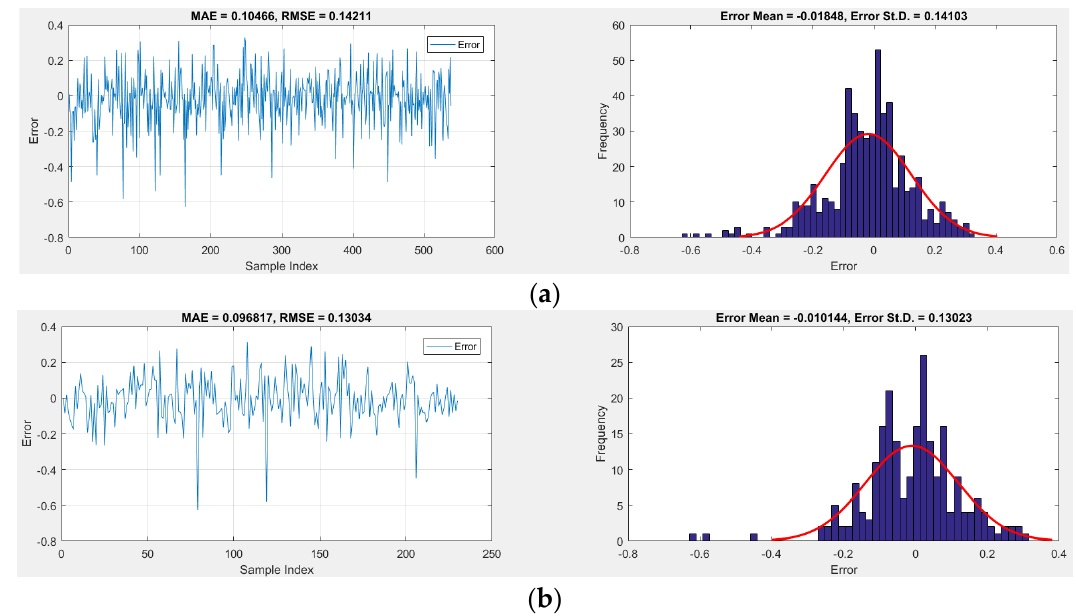
Figure 8. Frequency and minimum value of errors in HHO − ANFIS − 300 best fit structure. ( a ) Train- ing dataset. ( b ) Testing dataset.